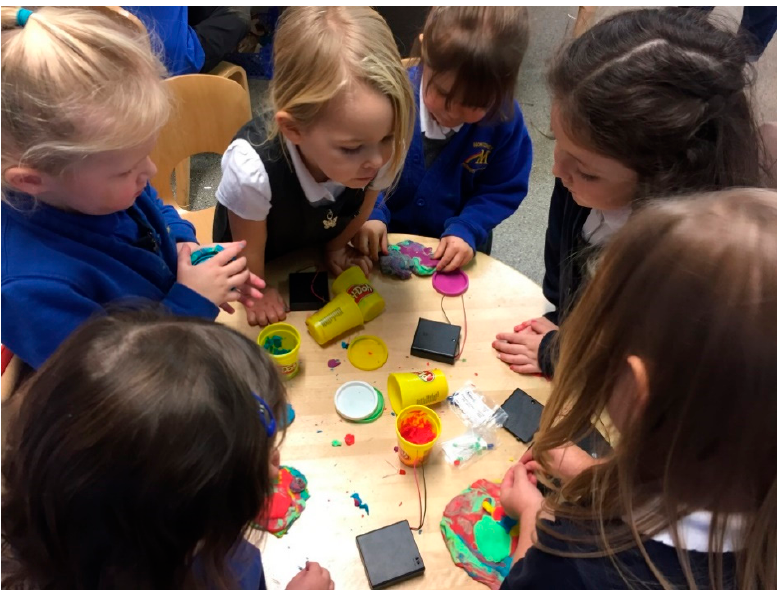
Figure 8. Girls making models of lit-up flowers to enhance their neighbourhood.